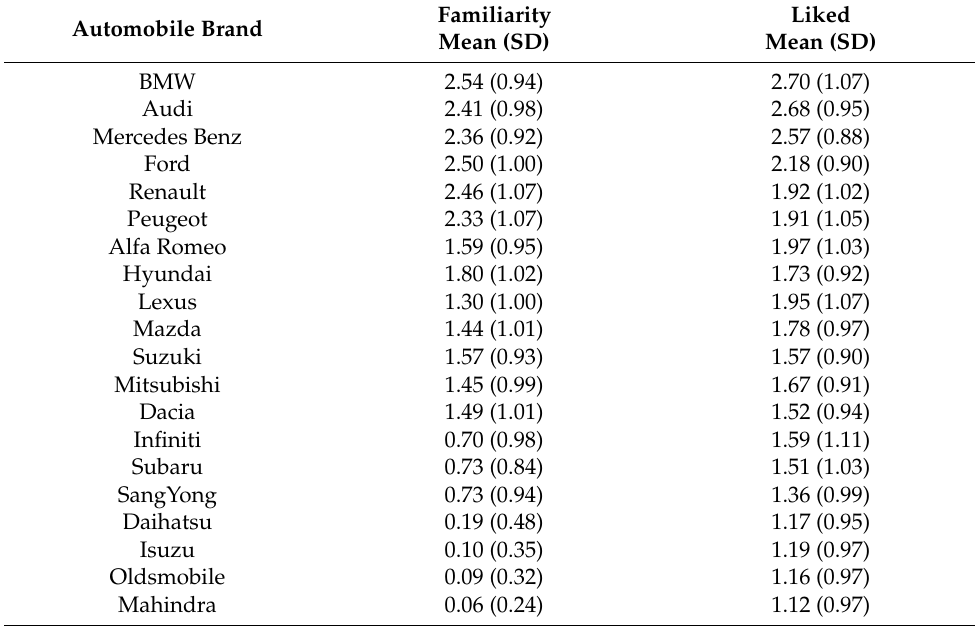
Table 1. Descriptive statistics on familiarity and level of being liked for each brand from the automo- bile